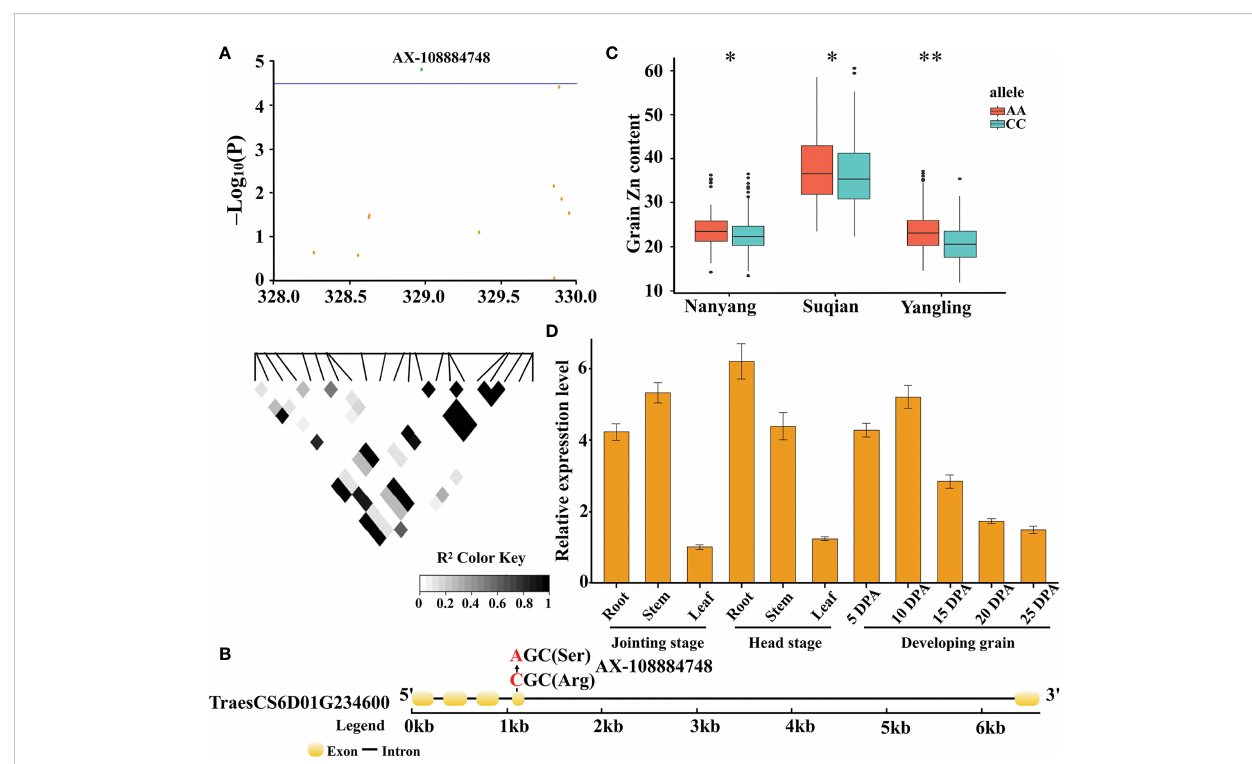
FIGURE 5 Candidate gene analysis based on the SNP AX-108884748 on chromosome 6D. Local Manhattan plot for the candidate region on chromosome 6D. The green dot represents the signi fi cant SNP AX-108884748. The corresponding LD block analysis of SNPs in this region is shown below. The degree of linkage is represented by the coef fi cient of r 2 (A) . Gene structure and location of the non-synonymous SNP for TraesCS6D01G234600 . Yellow rectangles and black lines represent exons and introns, respectively (B) . Boxplots for GZnC based on haplotype analysis (C) . Upper and lower edges of the box represent the 75th and 25th quantiles, respectively, and the whiskers show the 90th and 10th quantiles; the horizontal solid lines represent the median. Statistical signi fi cance was analyzed by t -test, * P ≤ 0.05; ** P ≤ 0.01. Expression pro fi le of TraesCS6D01G234600 in different tissues, as determined by qRT-PCR. The data was shown as the means ± Sd of n = 3 (D)